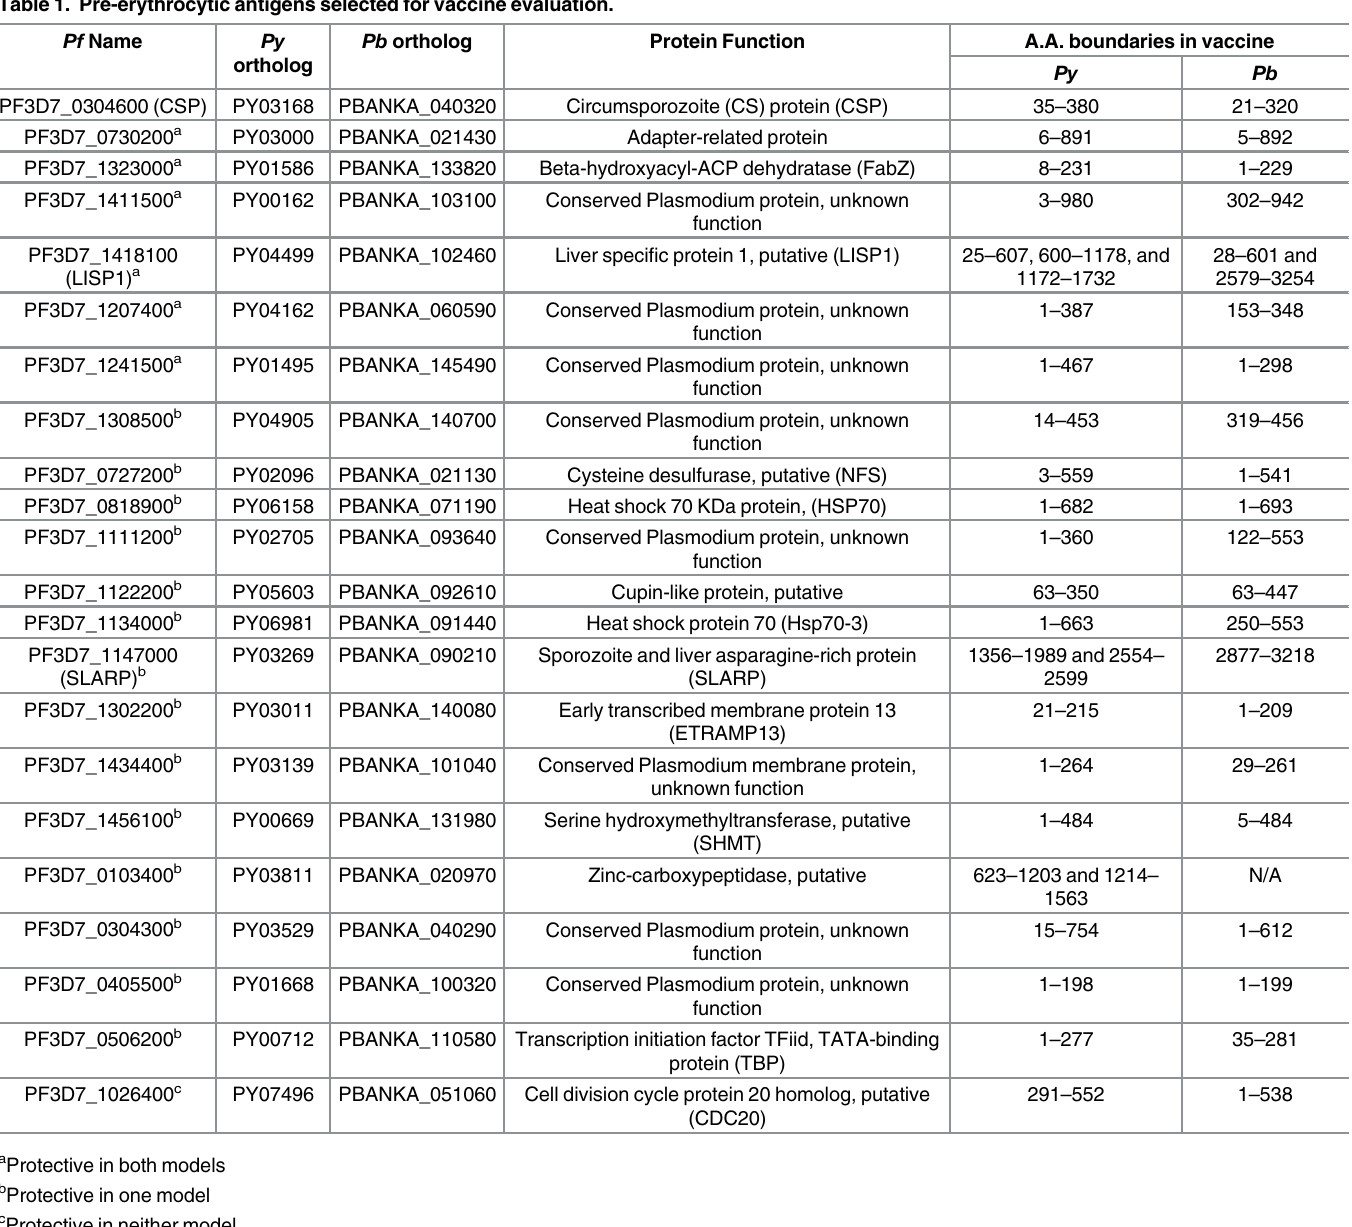
Table 1. Pre-erythrocytic antigens selected for vaccine